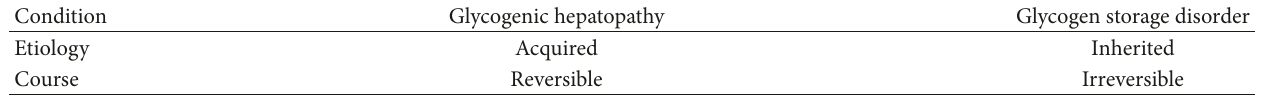
Table 3: Glycogenic hepatopathy versus glycogen storage disorder.